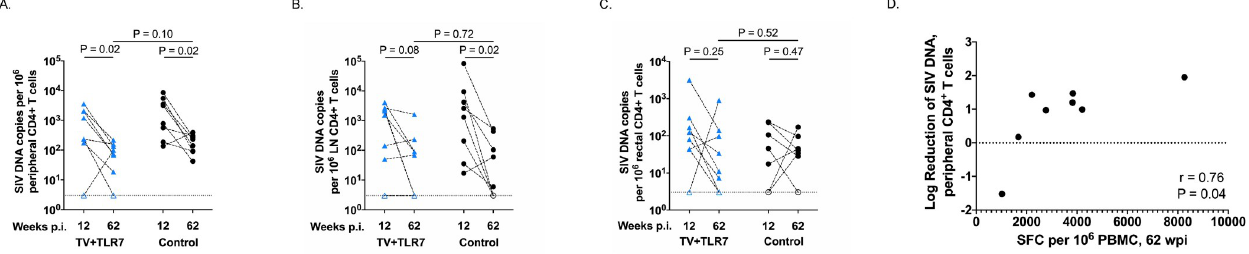
Fig 7. Impact of therapeutic vaccination and oral TLR-7 stimulation on SIV DNA persistence in CD4 + T cells of SIV-infected, ART-treated infant RMs. Comparison of frequency of estimated SIV DNA levels in (A) peripheral, (B) LN, and (C) rectal CD4 + T cells before (12 weeks post infection, wpi) and after (62 wpi) therapeutic vaccine regimen in TV+TLR7 and control RMs as determined by PCR. Dashed line represents the limit of detection and open symbols represent values below the limit of detection. Statistical analysis was performed using a two-sided Wilcoxon rank-sum tests (P < 0.05 was considered significant). (D) Association between log reduction of SIV DNA in peripheral CD4 + and LN CD4 + T cells from pre-vaccination to post-vaccination and magnitude of SIV-specific T cells at week 62 prior to ART interruption measured by IFN- γ ELISPOT in TV+TLR7 RMs. Two-sided Spearman rank correlation test was used to determine statistical significance. R value indicates correlation coefficient.